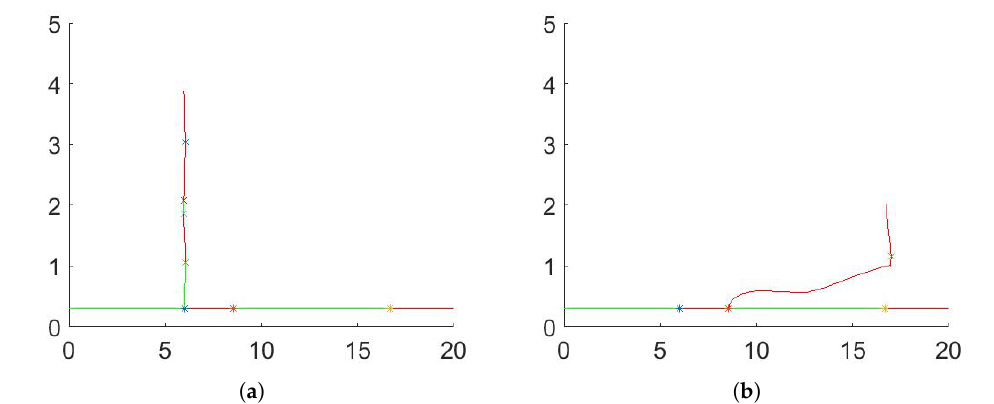
Figure 16. Periodic solutions from Hopf bifurcation ( ∗ ) at different values of τ for the system (1), ( a ) τ = 5.99; and ( b ) τ = 8.5669; at E 1 = ( 0.1,0.39,2.62,11.41 ) . Stability switching occurred from stable (green line) to unstable (red line) and vice